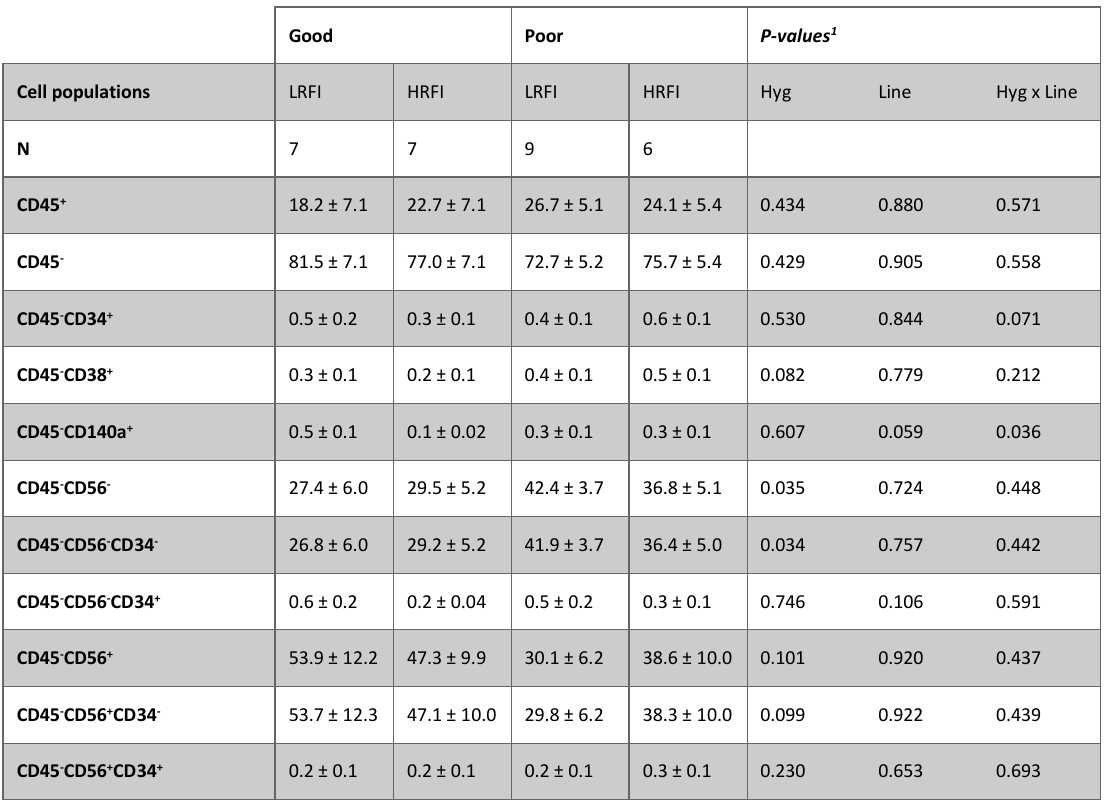
Table 3 : Percentage of cell populations in subcutaneous adipose tissue of low (LRFI) and high (HRFI) residual feed intake pigs housed in good or poor hygiene conditions for six